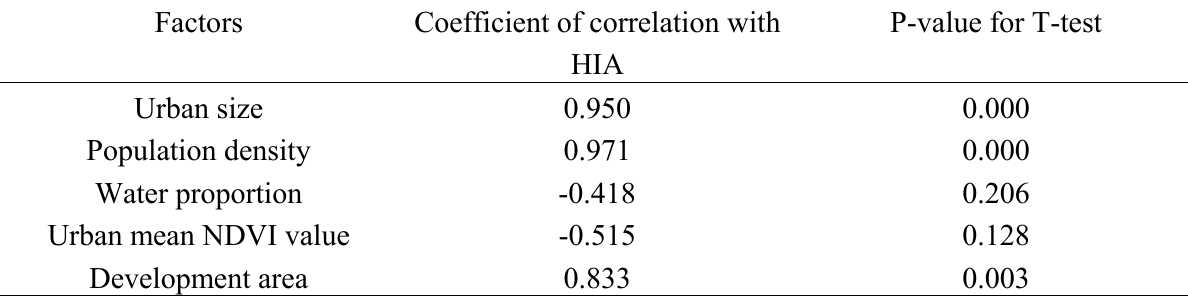
Table 3. Results of correlation analysis between HIA and five factors for ten cities in Guangdong